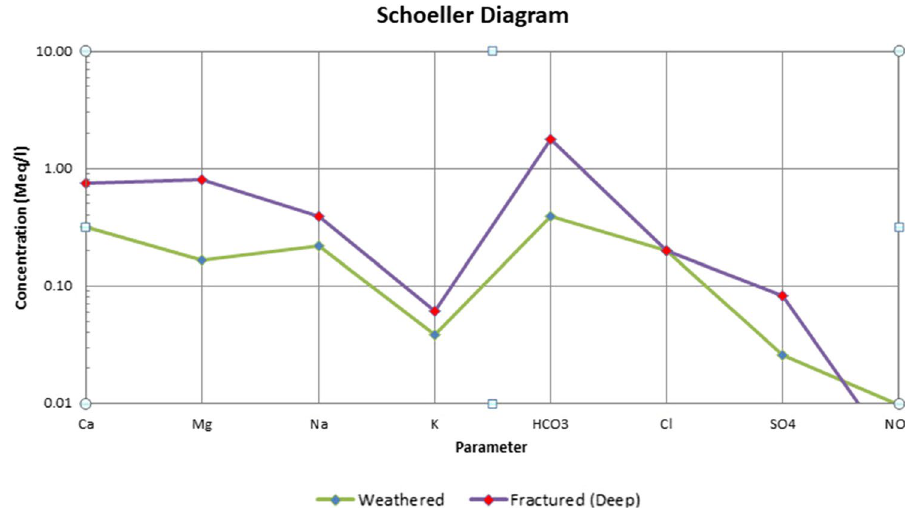
showing dominance of ions in groundwater